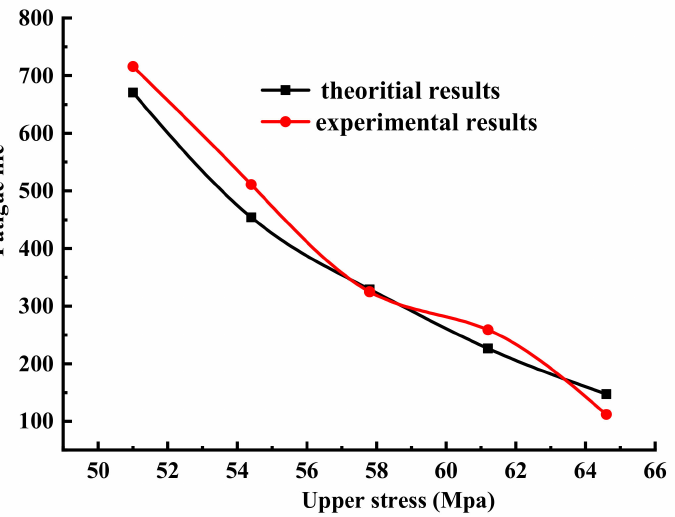
Figure 12. Variation law of fatigue life of sandstone samples with upper limit stress when the lower limit stress is fixed ( σ min = 20.4